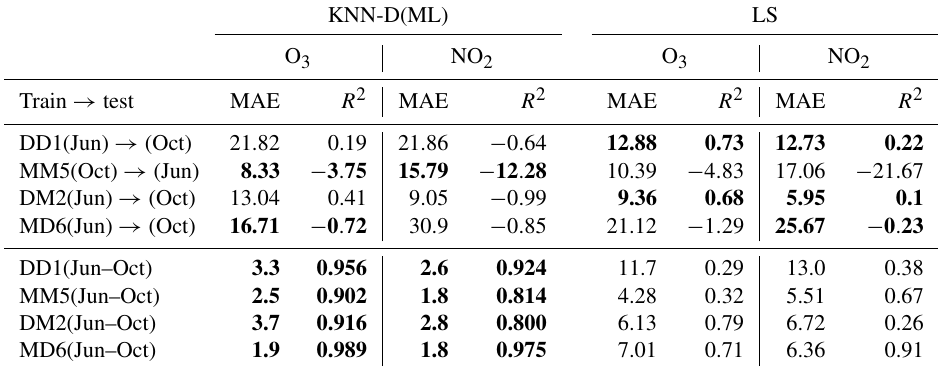
Table 6. A demonstration of the impact of data diversity and data volume on calibration performance. All values are averaged across 10 splits. The results for LS diverged for some of the datasets for a few splits, and those splits were removed while averaging to give LS an added advantage. Bold values indicate the better-performing algorithm. The first two rows present the performance of the KNN-D(ML) and LS calibration models when tested on data for a different season (deployment) but in the same site. This was done for the DD1 and MM5 sensors that did not participate in the swap-out experiment. The next two rows present the same but for sensors DM2 and MD6 that did participate in the swap-out experiment, and thus, their performance is being tested for not only a different season but also a different site. The next four rows present the dramatic improvement in calibration performance once datasets are aggregated for these four sensors. NO 2 calibration is affected worse by these variations (average R 2 in first four rows being − 3 . 69) than O 3 calibration (average R 2 in first four rows being − 0 .